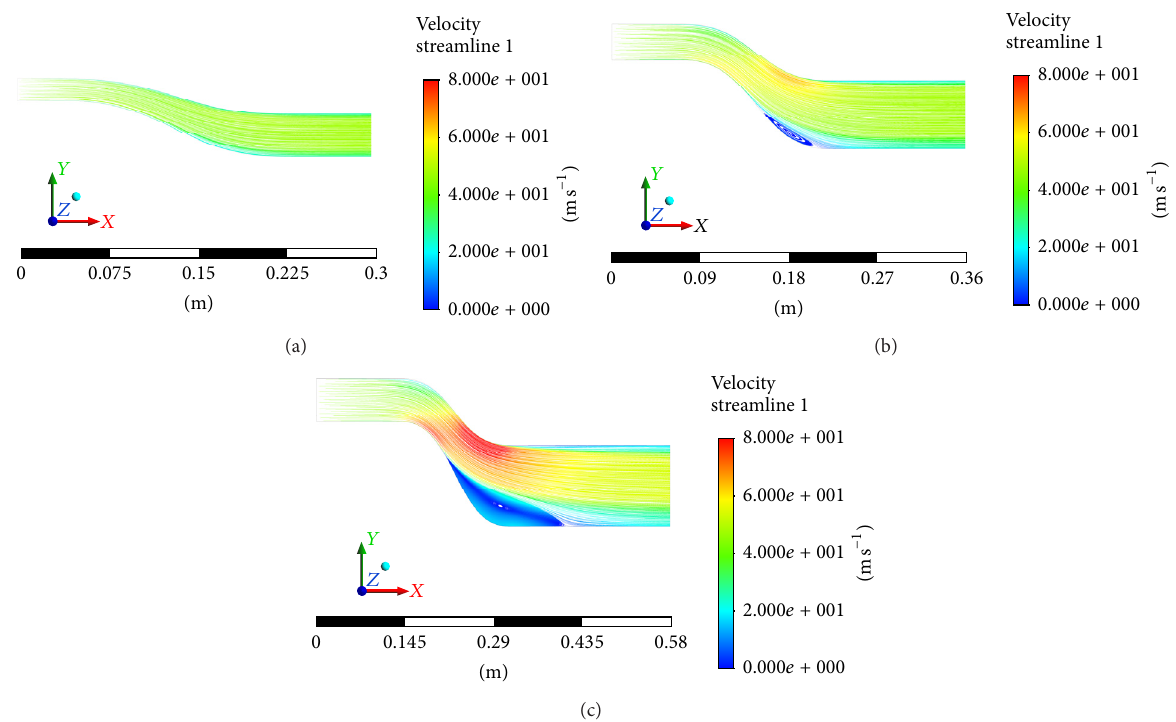
Figure 11: Velocity streamlines at 𝑅 𝑟 = 1.9 and 𝛼 0 = 0 ∘ for 𝑌 = 0.2 (a), 𝑌 = 0.5 (b), and 𝑌 = 0.8